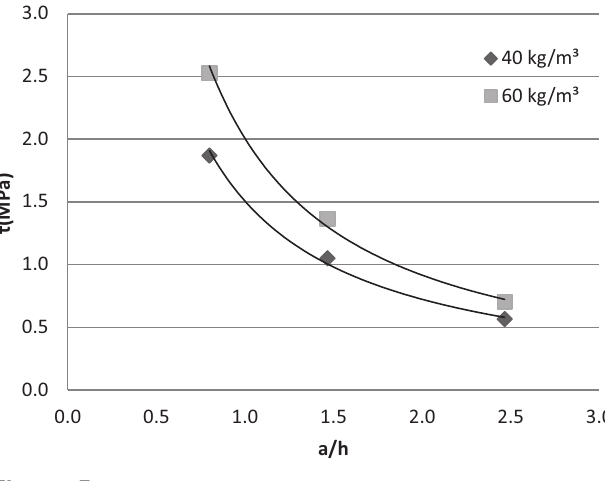
Cracking moment x rotation for average values in each series Ratio between cracking moments according to the